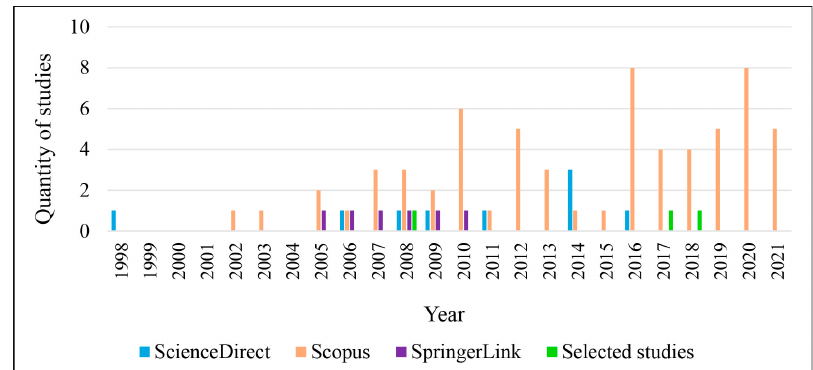
Figure 5. Quantity of works for databases.